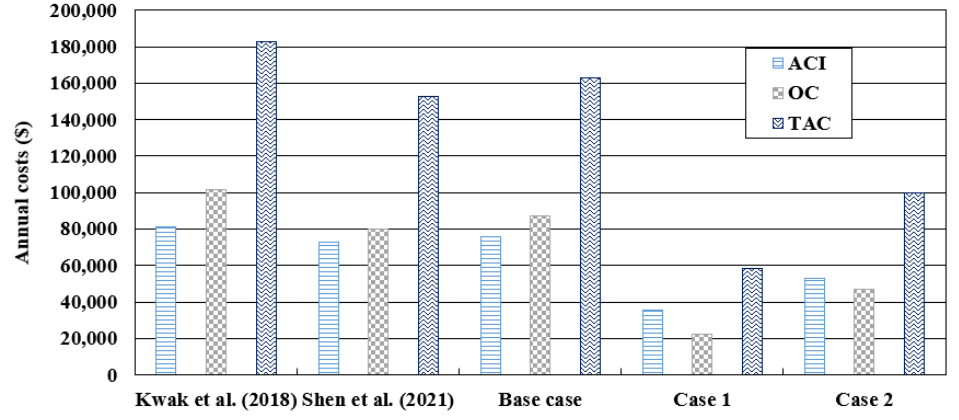
Figure 17. Annual costs of the BOG re-liquefaction systems [4,25]. Table 9. ACI, OC, and TAC of the BOG re-liquefaction systems. Parameters